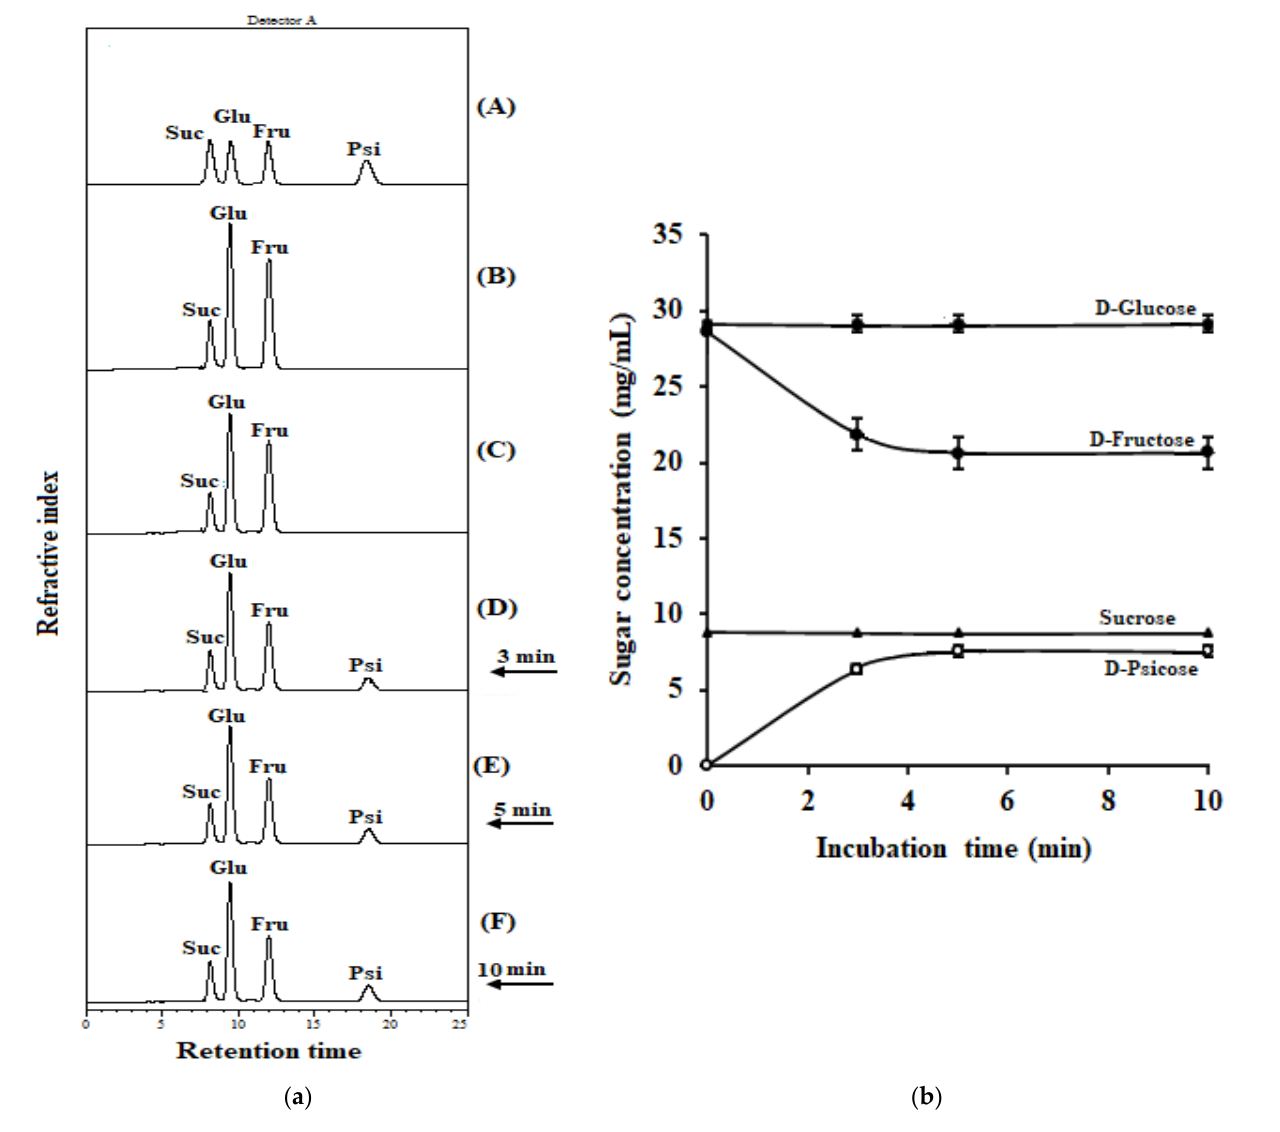
Figure 4. Conversion of D-fructose in coconut water into D-psicose by IfDPEase (15 µ M). ( a ) HPLC analysis profile of the IfDPEase reaction to coconut water; ( A ) standard sucrose, D-glucose, D-fructose, and D-psicose; ( B ) coconut water without enzyme; ( C ) the reaction with the denatured enzyme; ( D – F ) the reaction at 3, 5, and 10 min, respectively. ( b ) Concentration of sugars changed during the reaction of IfDPEase with coconut water.